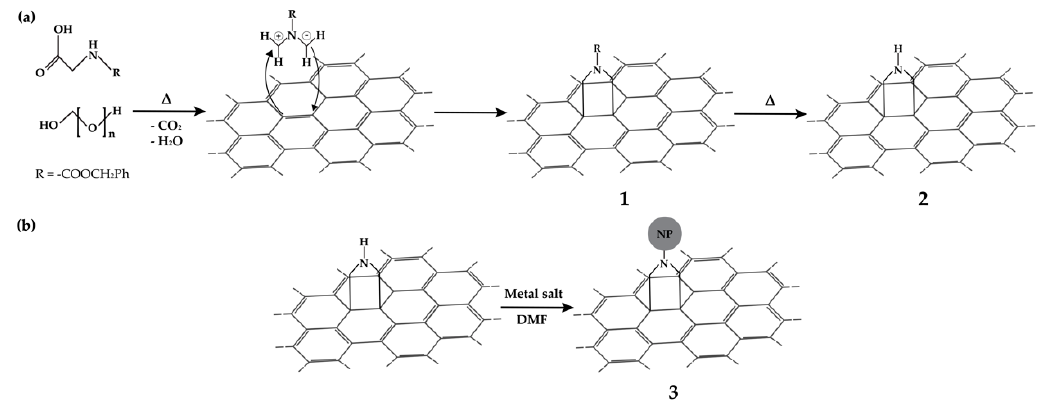
Figure 1. Schematics of the reactions carried out: ( a ) 1,3-dipolar cycloaddition (DCA) reaction, where 1 and 2 are the products; ( b ) anchoring of metal nanoparticles (product 3) on the pyrrolidine groups formed by the DCA reaction.